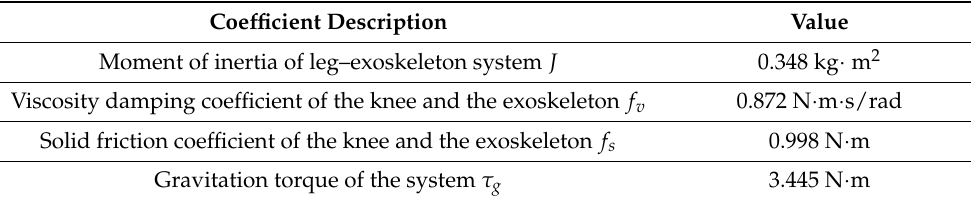
Table 1. The identified parameters of exoskeleton system with sitting patient [14].